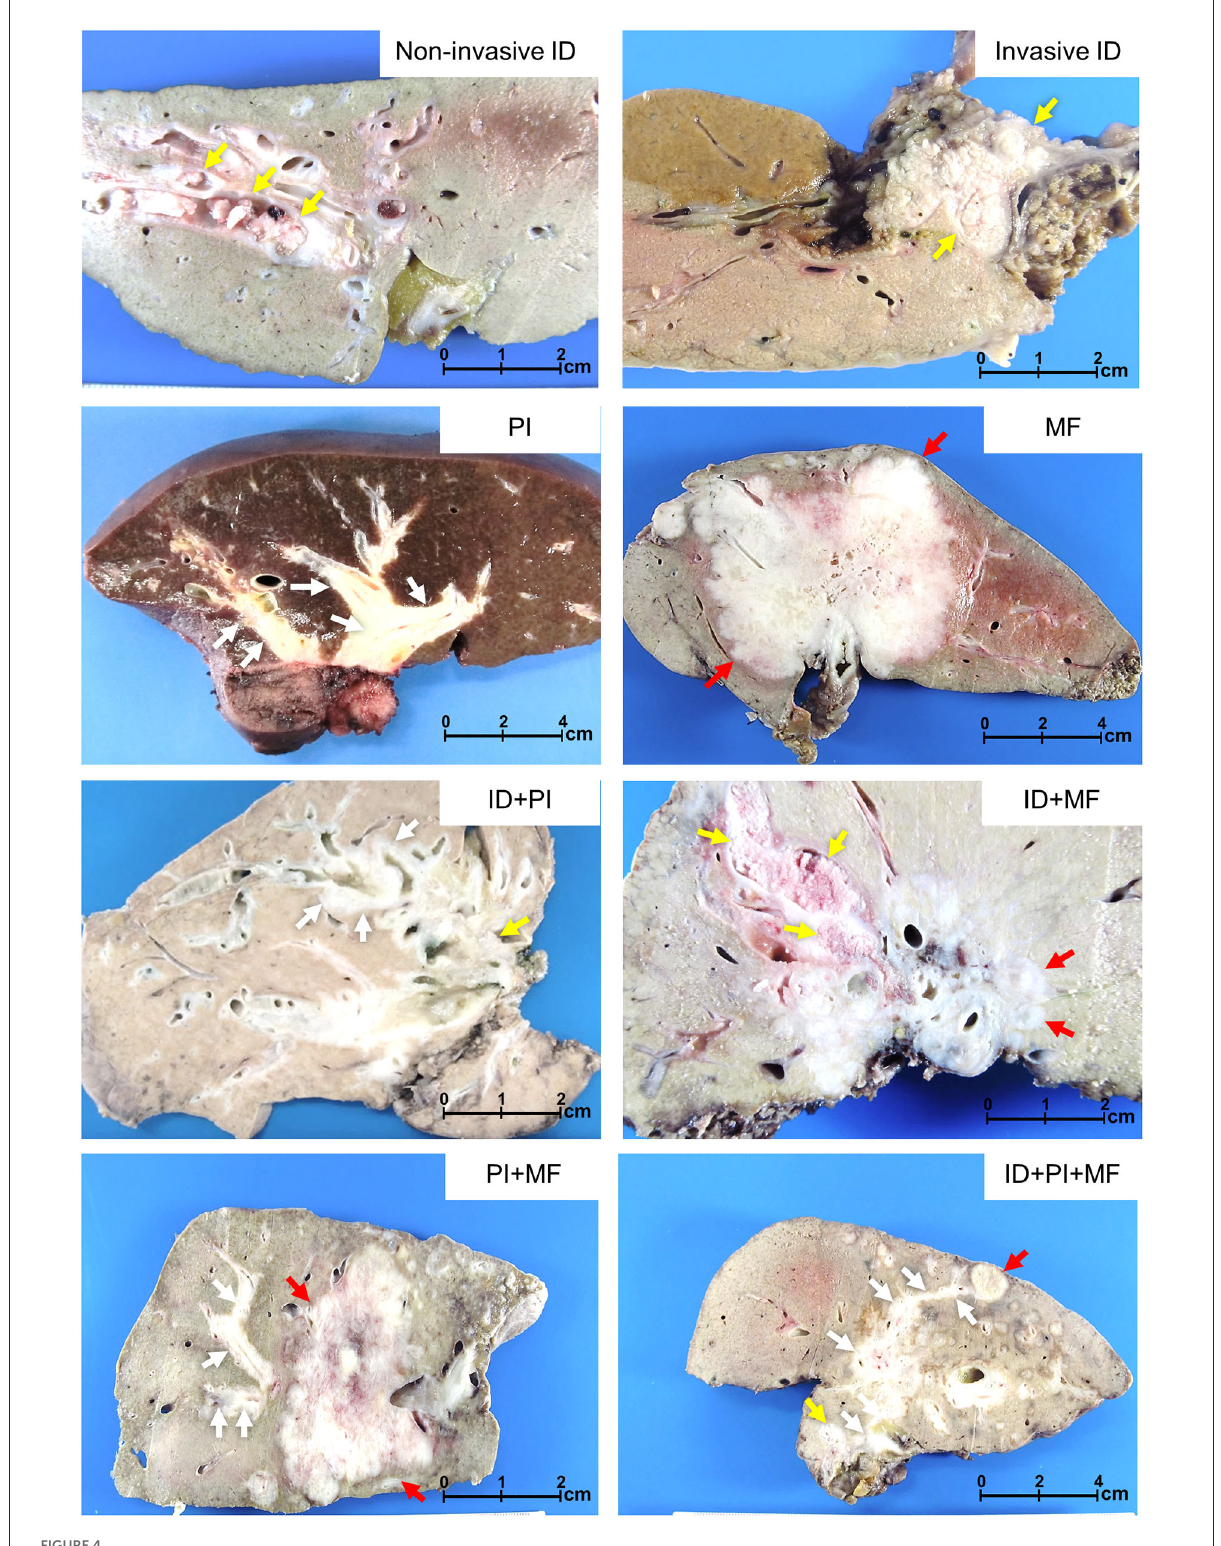
FIGURE4 Growth patterns of perihilar cholangiocarcinoma. Non-invasive intraductal (ID), invasive ID, periductal infiltrating (PI), mass-forming (MF), and mixed types comprising ID + PI, ID + MF, PI + MF, and ID + PI + MF. Yellow, white, and red arrows indicate ID, PI, and MF,